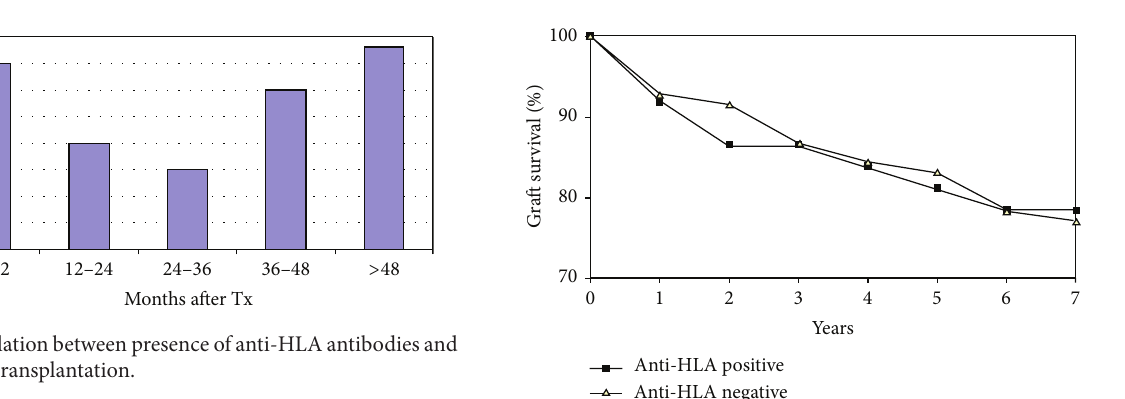
tacrolimus group in comparison to 12 of 27 patients (44%) in nontacrolimus group. Graft loss occurred in 7 (23%) patients in the anti-HLA positive group and 20 (22%) in the anti-HLA negative group ( 𝑃 = 0.79 , OR = 0.76 [0.26– 2.25]). Presence of anti-HLA antibodies was not a significant predictor of patients and grafts survival in analyses of the whole group or separately in anti-HLA I and anti-HLA II positive groups (Figure 2). Graft loss occurred in 8 patients in anti-MICA positive group (22%) and 19 (23%) in anti- MICA negative group ( 𝑃 = 0.86 , OR = 1.03 [0.38–2.76]) (Figure 3). Presence of anti-HLA or anti-MICA antibodies was also not a predictive factor of graft failure in an analysis which excluded the 11 patients with known “nonimmunolog- ical” cases of death. No significant correlation was detected between patients’ survival and the following variables: time since liver transplantation to blood collection, primary liver disease (both “immunological” and “nonimmunological”), HBV and HCV infection, or basiliximab